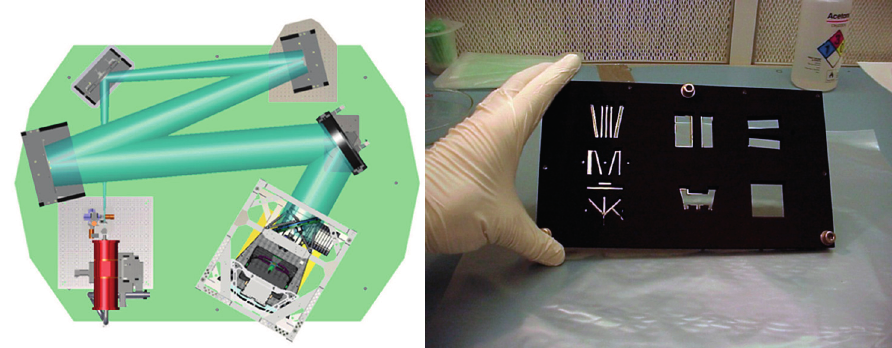
Figure 16. Spatial testing. The figure on the left shows how light from a collimated source ( left ) is expanded and projected to the instrument ( right ). The figure on the right shows the spatial mask with the various spatial targets that were used to characterize the OLI spatial